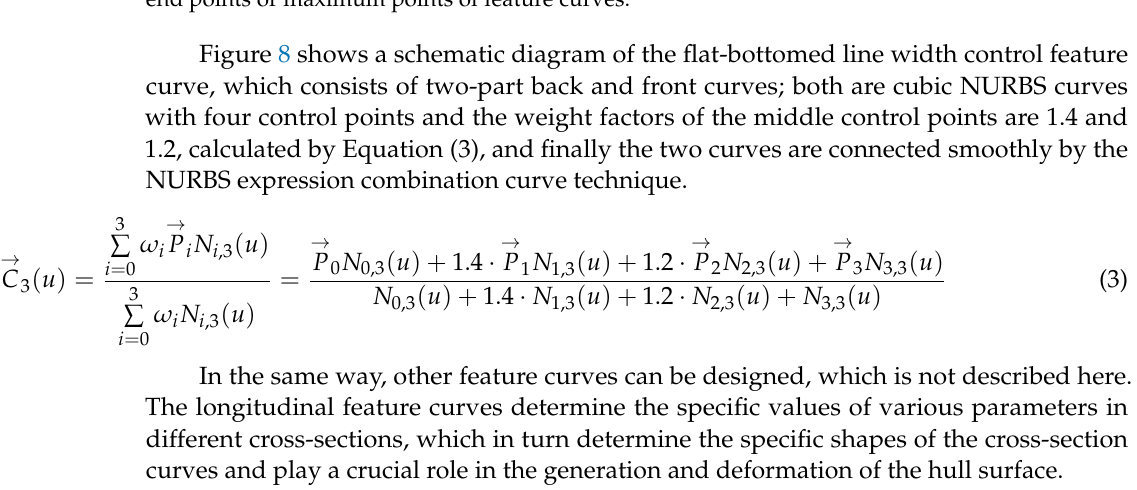
Figure 7. Schematic diagram of longitudinal feature curve of Series 60 vessel. Solid, dashed, and dash-dot black lines are individual longitudinal feature curves, and red points are the corresponding end points or maximum points of feature curves.